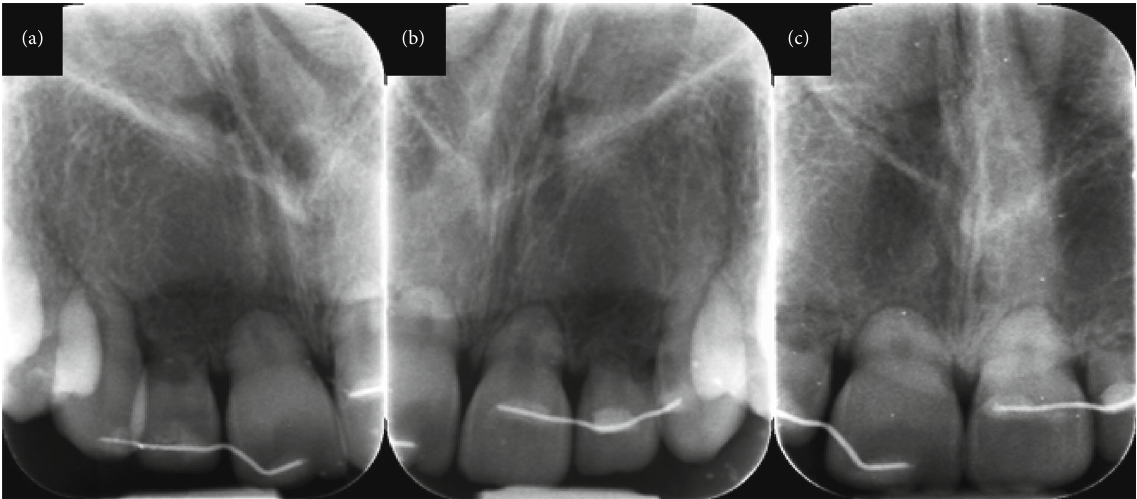
Figure 4: (a) and (b) Periapical radiographs of the upper incisors at 6 months. Slight radiolucent lesions around lateral incisors still persist. (c) Periapical radiograph of the upper incisors at 24 months. Complete healing with no radiolucent area around maxillary lateral